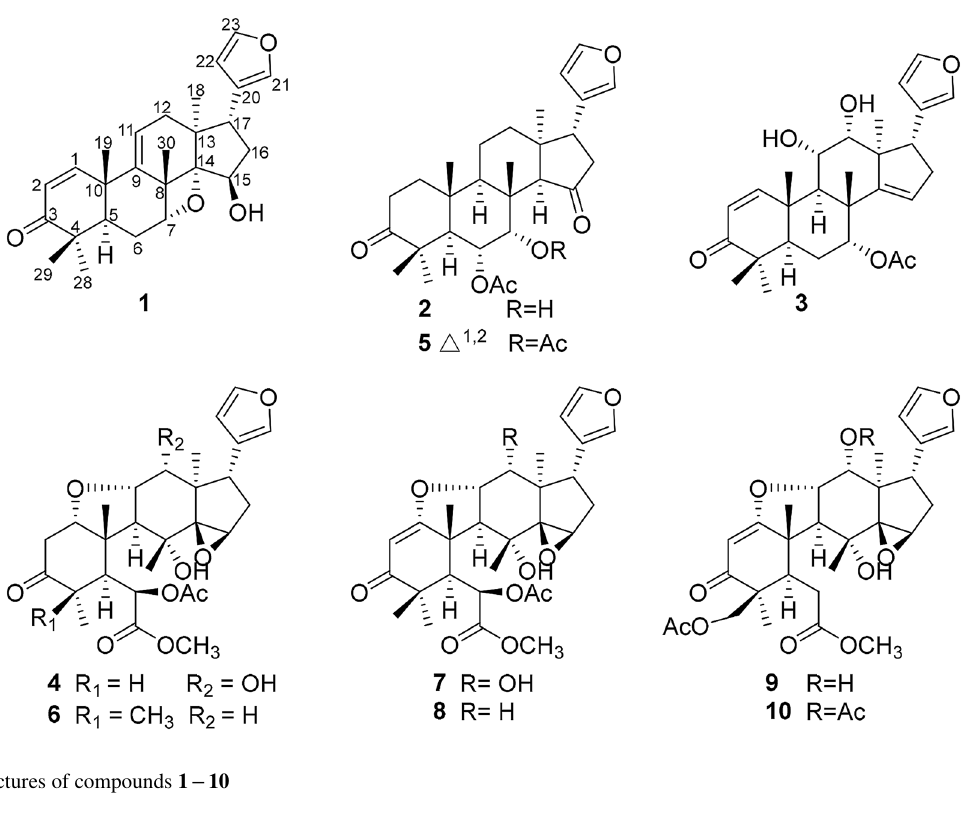
Fig. 1 The structures of compounds 1 − 10